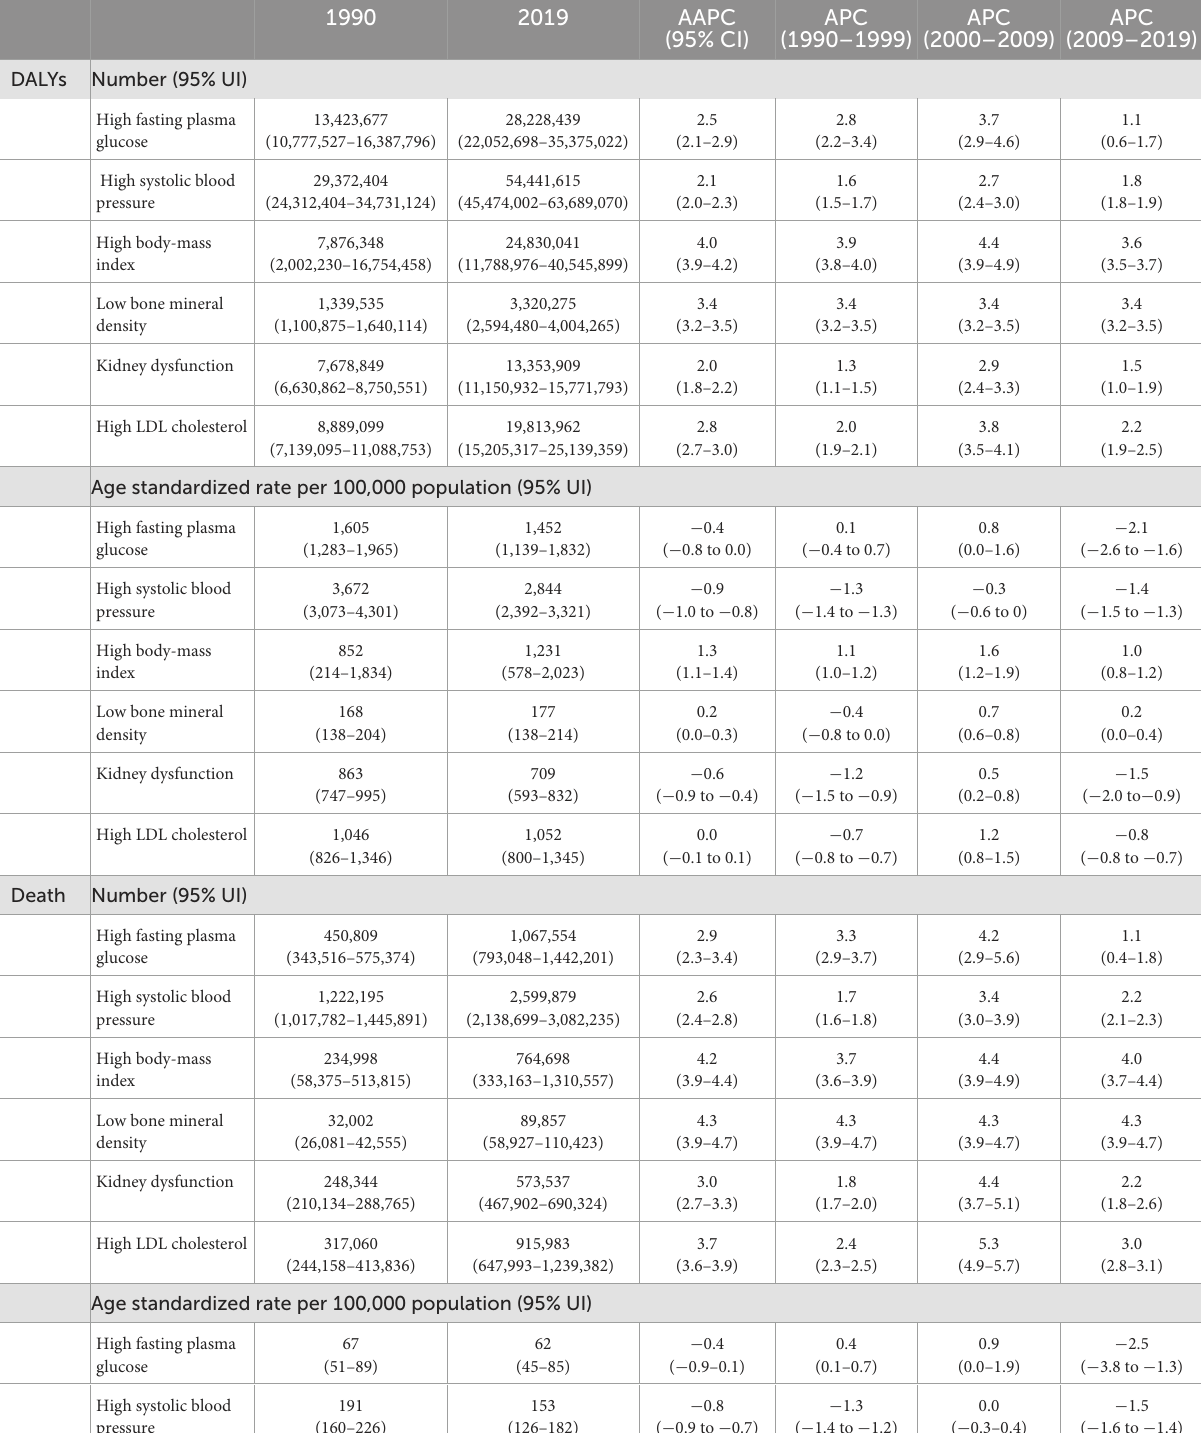
TABLE 1 Trends in the number and age-standardized rate of DALYs and death attributable to six metabolic risk factors for both sexes in China,